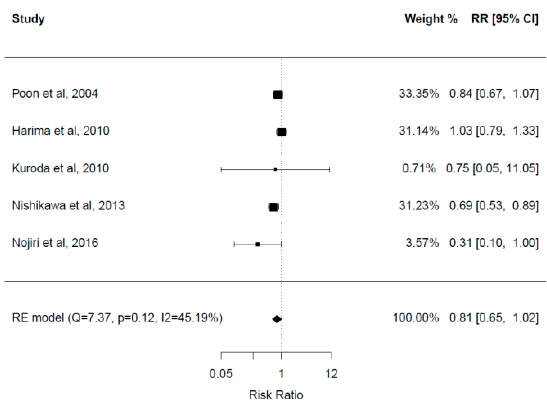
Figure 4. Forest plot for mortality rate [23,28,31–33].